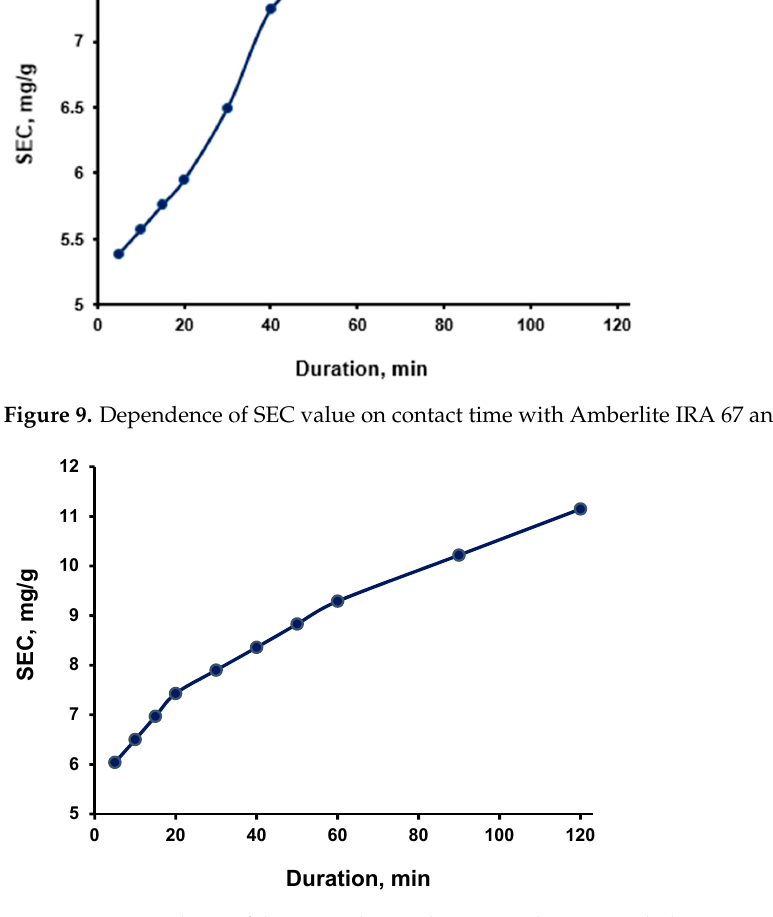
Figure 10. Dependence of the SEC value on the contact duration with the AN-2FN anion-exchange resin.